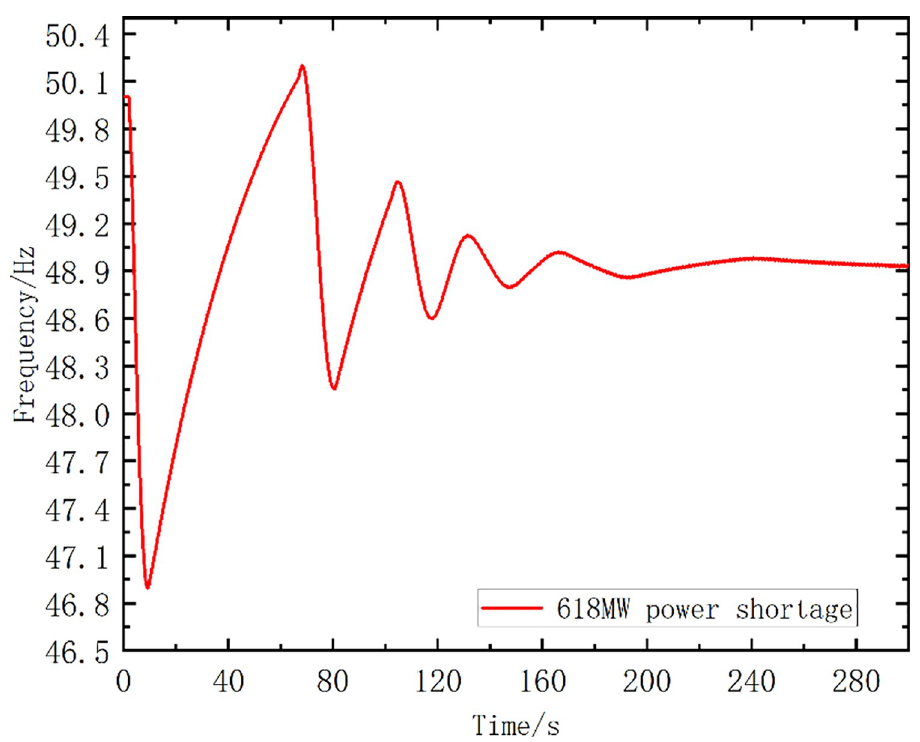
Fig 8. The frequency curve without any measures.